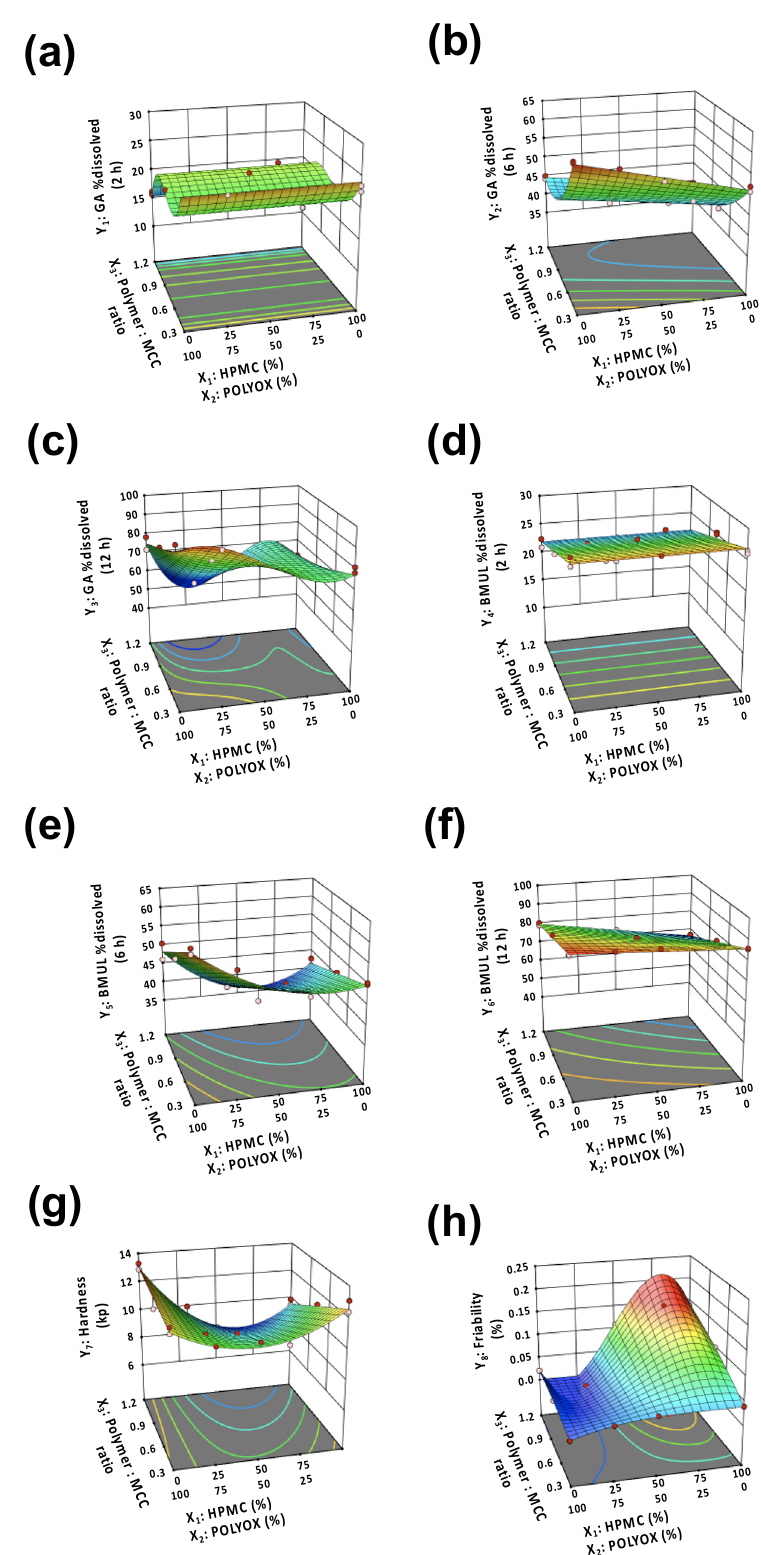
Figure 2. Three-dimensional surface plots of ( a ) Y 1 : % dissolved (2 h) of GA; ( b )Y 2 : % dissolved (6 h) of GA; ( c ) Y 3 : % dissolved (12 h) of GA; ( d ) Y 4 : % dissolved (2 h) of BMUL; ( e ) Y 5 : % dissolved (6 h) of BMUL; ( f ) Y 6 : % dissolved (12 h) of BMUL; ( g ) Y 7 : hardness; ( h ) Y 8 : friability.